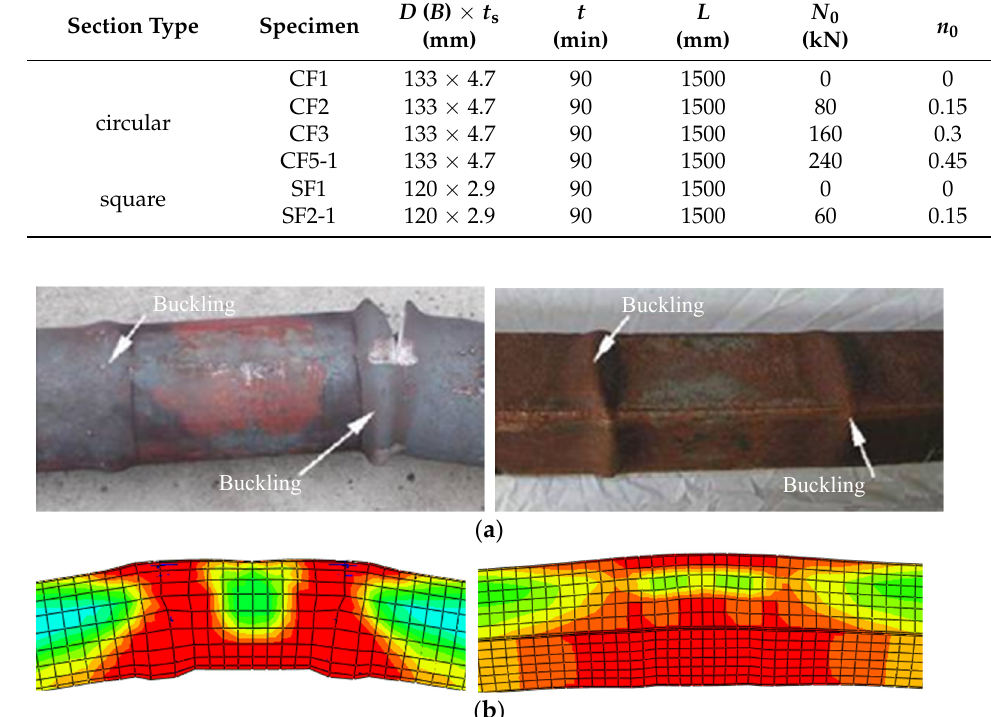
Figure 4. Failure morphology of typical components by experiment and numerical simulation: ( a ) Failure morphology of experiment columns; ( b ) Failure morphology of numerical calculation columns.